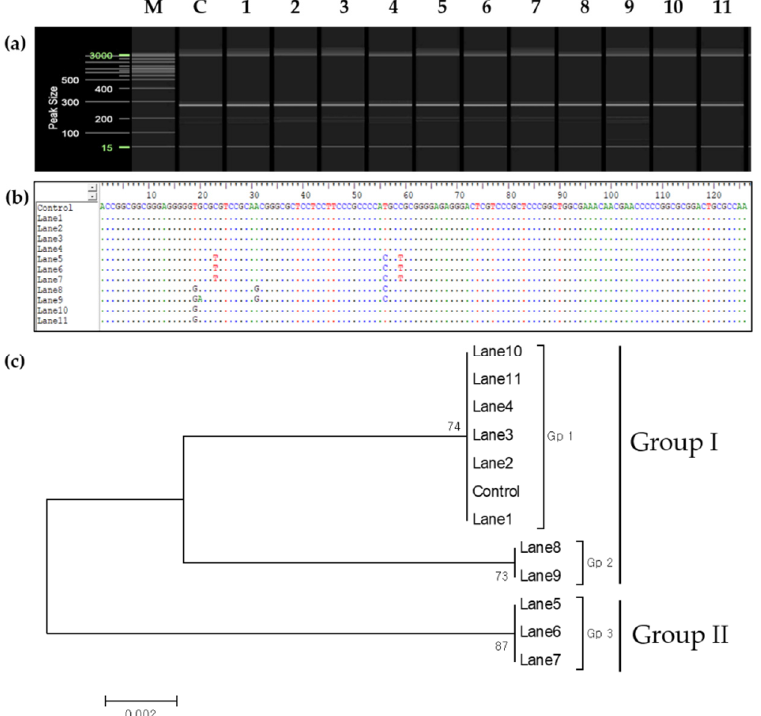
Figure 8. Maximum likelihood phylogenetic tree of regenerated anther-derived plants based on sequences in the internal transcribed spacer (ITS) 1 region. ( a ) Amplification patterns of the ITS1 region. ( b ) Alignment of the nucleotide sequence in the ITS1 region. Lanes 1–11: plants obtained through anther culture; control: leaf from the donor plant. ( c ) Phylogenetic analysis. M, molecular marker (20 and 100 bp DNA ladder); C, control plant; GP, subgroup.